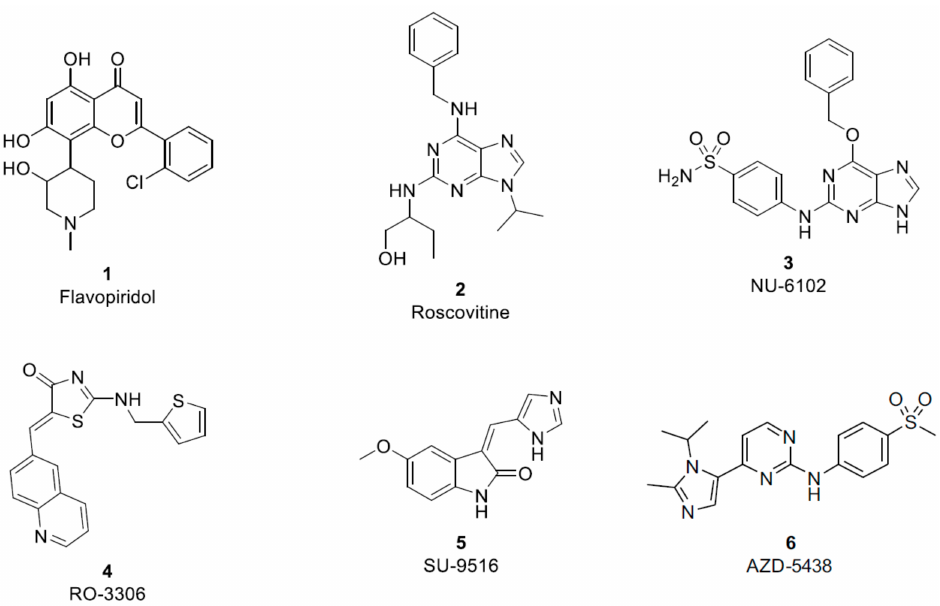
Figure 1. CDK-1/cyclin B